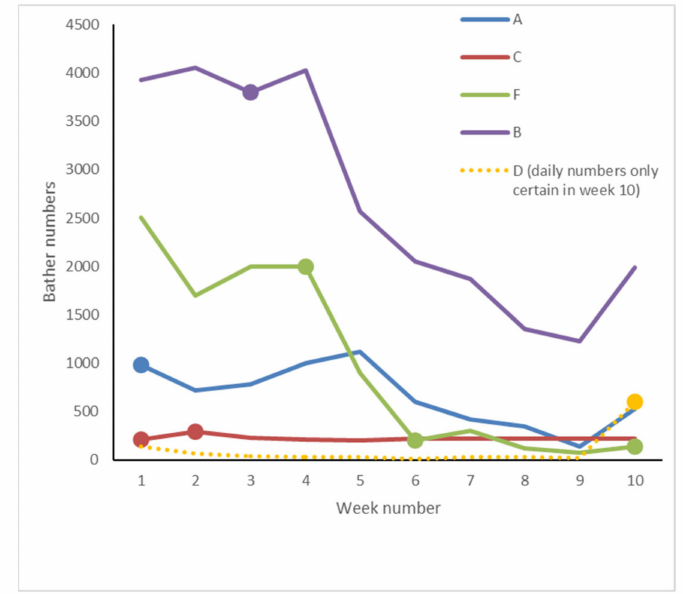
Figure 1. Daily bather numbers and Cryptosporidium detections (represented by circles) at five pools (A, B, C, D and F) provided the total bather number for the day of sampling. School holidays likely influenced bather numbers at most pools. Pool D was in Scotland where only sampling weeks 1 and 2 were in the summer holidays and week 10 was in the October holiday. For all other pools sampling weeks 1 to 5 were in the summer holidays.